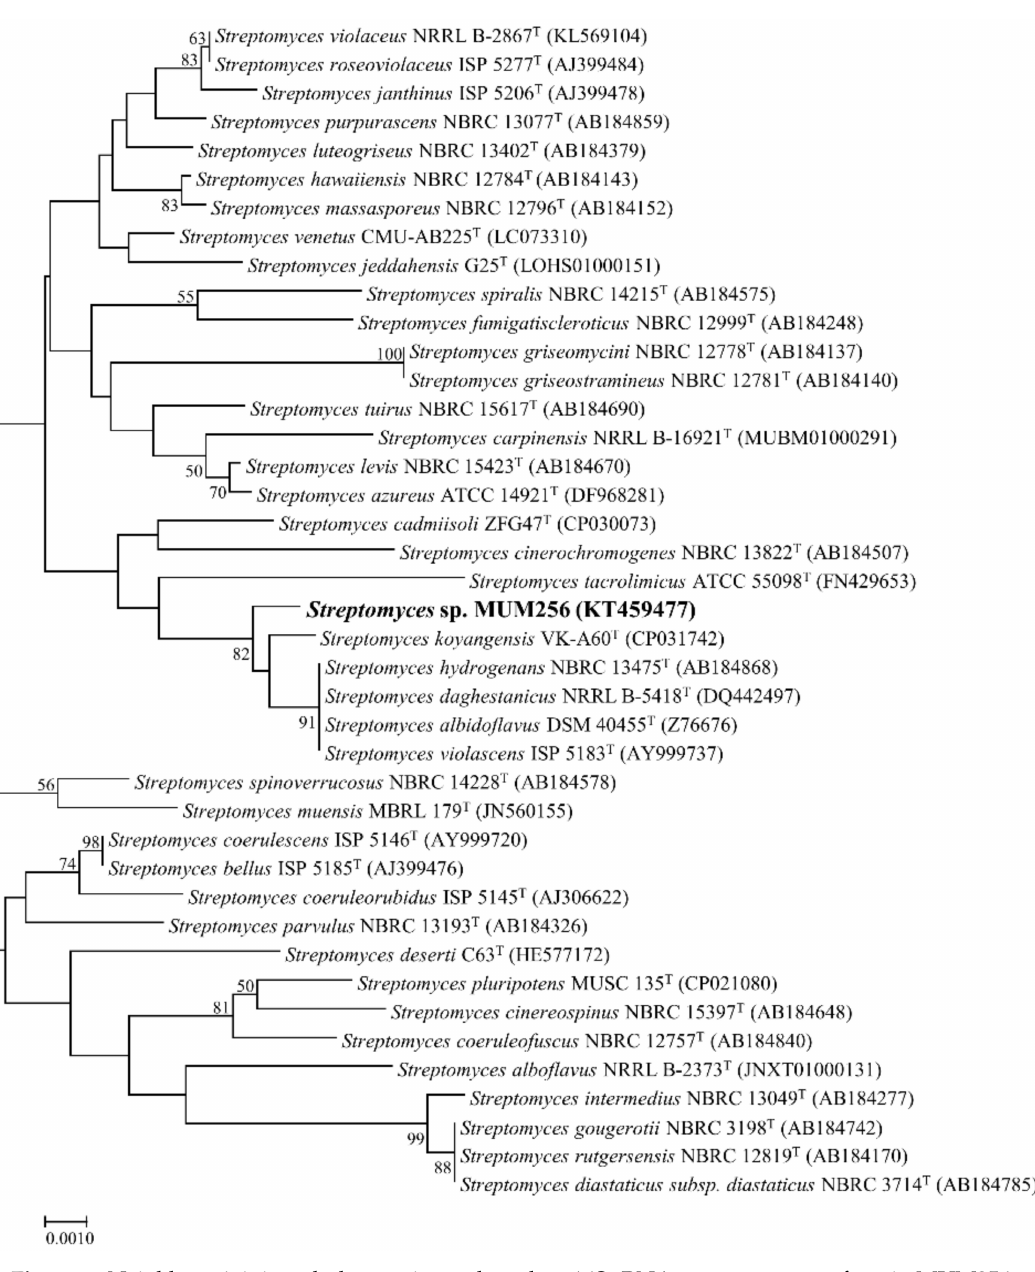
Figure 2. Neighbour-joining phylogenetic tree based on 16S rRNA gene sequence of strain MUM256 (1343bp). The tree illustrates the relationship between strain MUM256 and closely related strains. Numbers at nodes indicate percentages of 1000 bootstrap re-samplings. Bar, 0.001 substitutions per